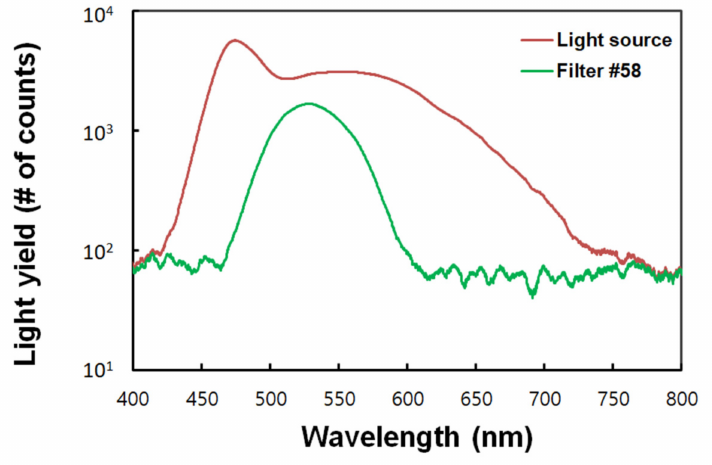
Figure 1. Light transmittance characteristics of Kodak Wratten filter No. 58.